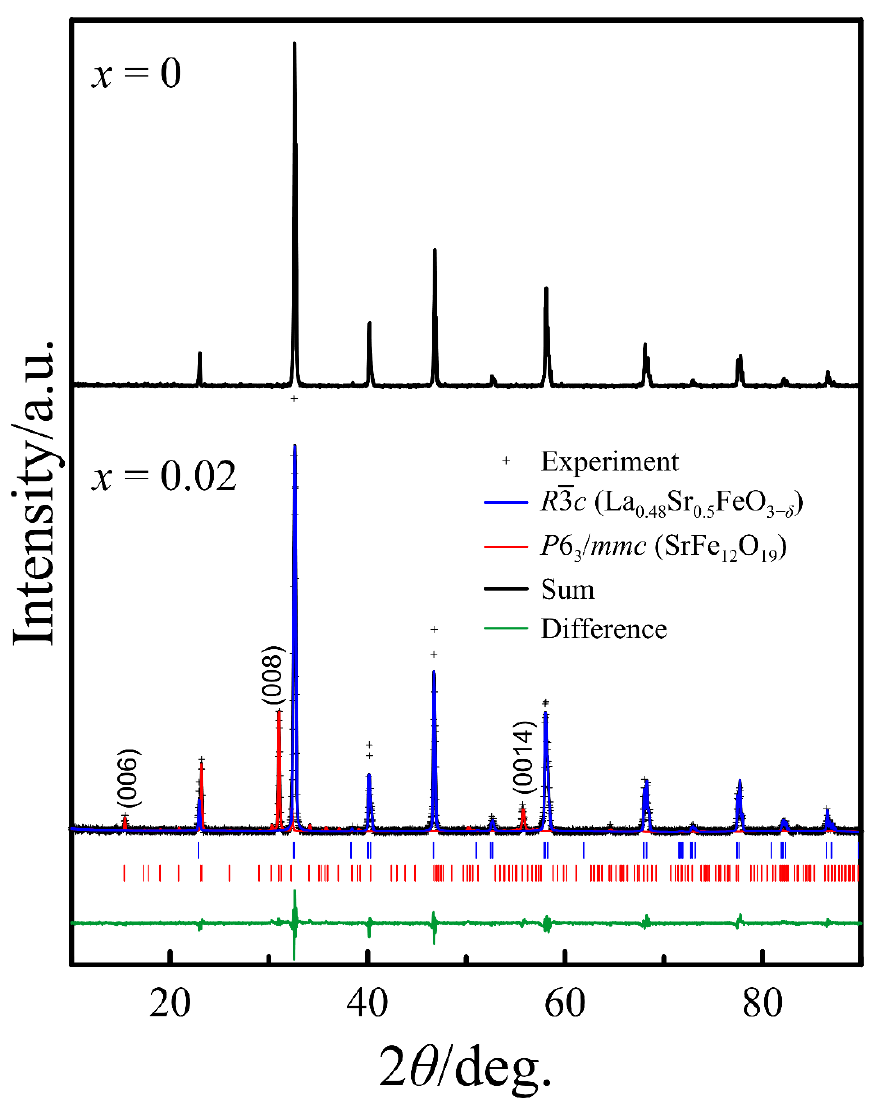
Figure 14. XRD patterns of the surface of ceramic discs with x = 0 and 0.02 compositions. Preferred orientation is along c-axis.